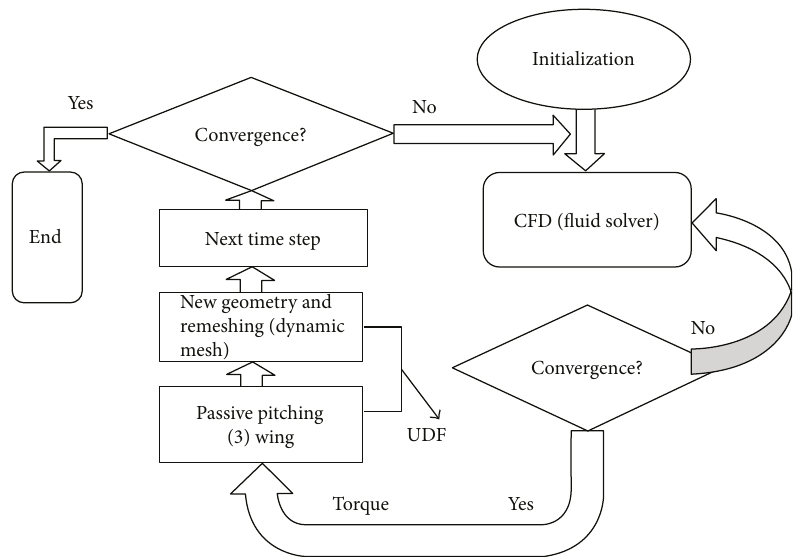
Figure 2: The schematic of coupling method.